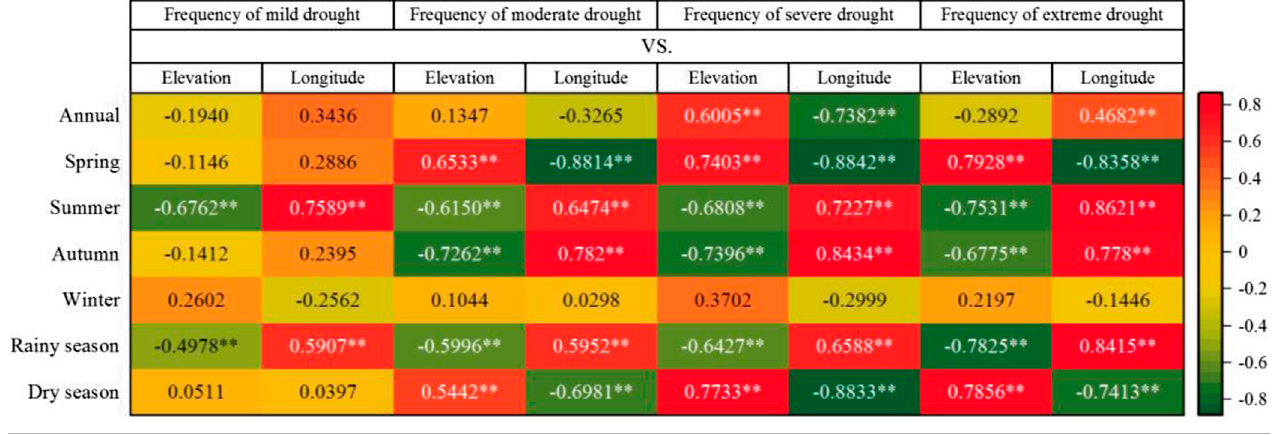
Frontiers in Environmental Science |